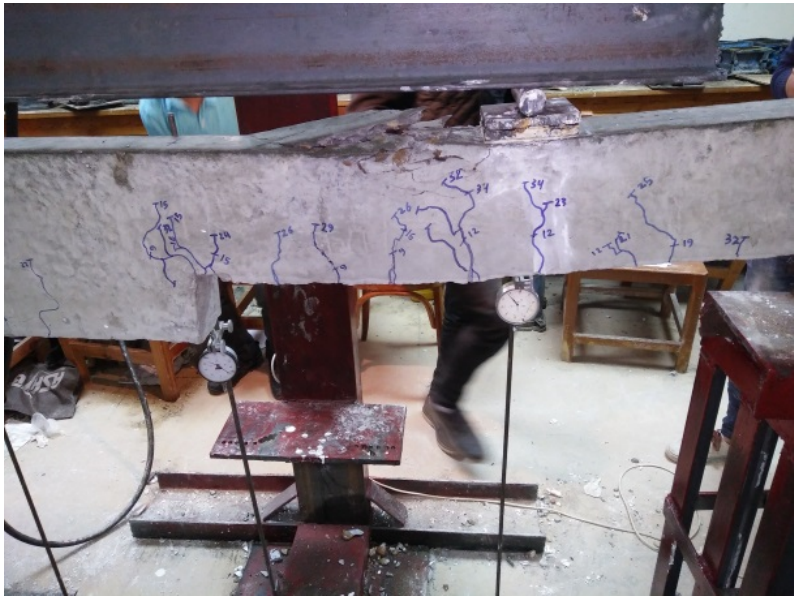
Figure 17. Crack pattern of beam B5.